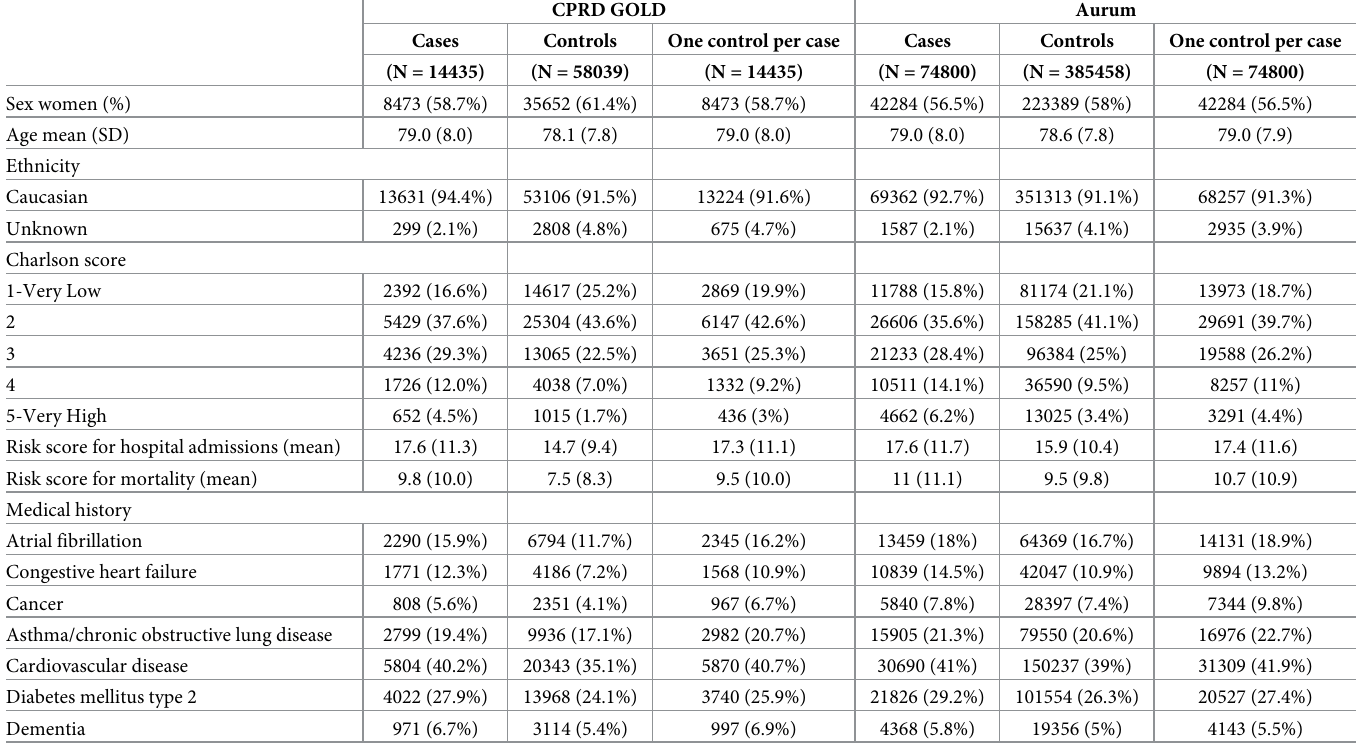
Table 1. Characteristics of cases with ADR-related hospital admissions and matched controls stratified by data